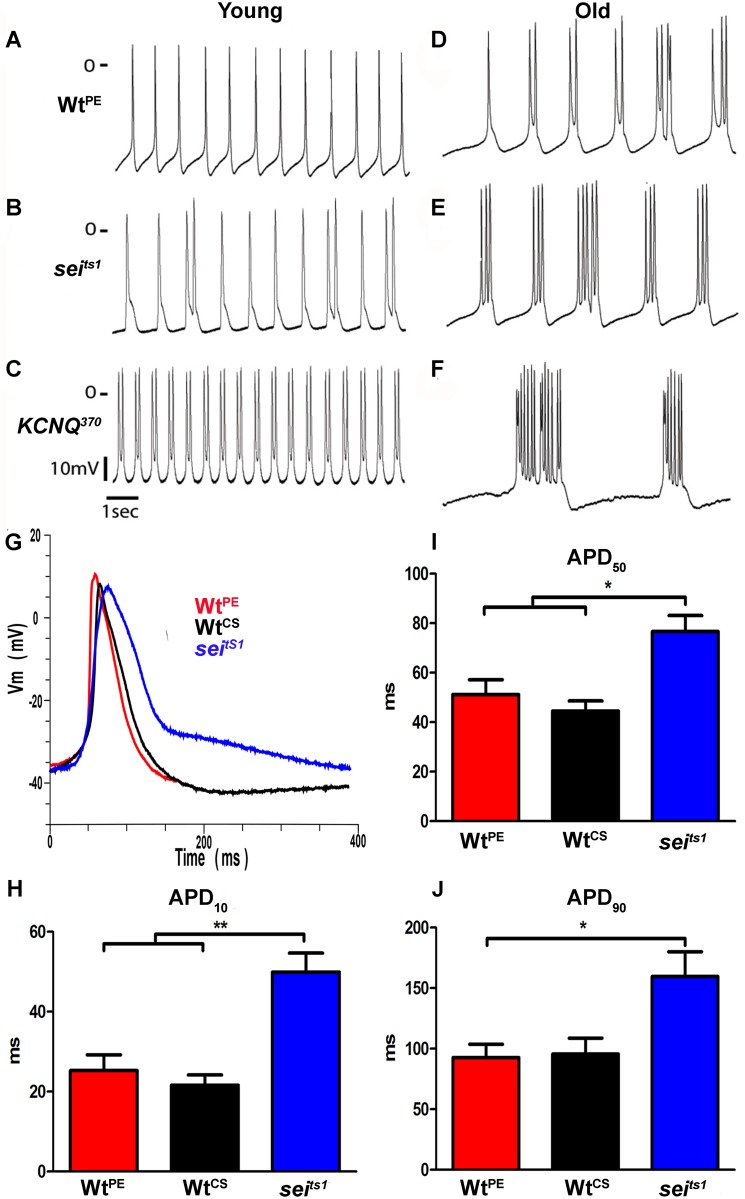
Spontaneous action potentials from Drosophila myocardial cells.Action potentials were recorded using intracellular recording techniques from fly hearts in which contractions had been blocked with 10uM blebbistatin. (A,C,E) Action potentials from myocardial cells in hearts from young flies (1–2 week old). (B,D,F) Action potentials from myocardial cells in hearts from old flies (4–6 weeks). (G) Superimposed action potentials from two wt lines (WtPE-red; WtCS-black) and seits1 mutant (blue) hearts. (H-J) Action Potential Duration (APD) was measured for single-peak APs at the point where the membrane voltage had repolarized to 10% (H), 50% (I) and 90% (J) of its maximum depolarized potential. (one-way ANOVA;*p<0.05; ** p<0.01).